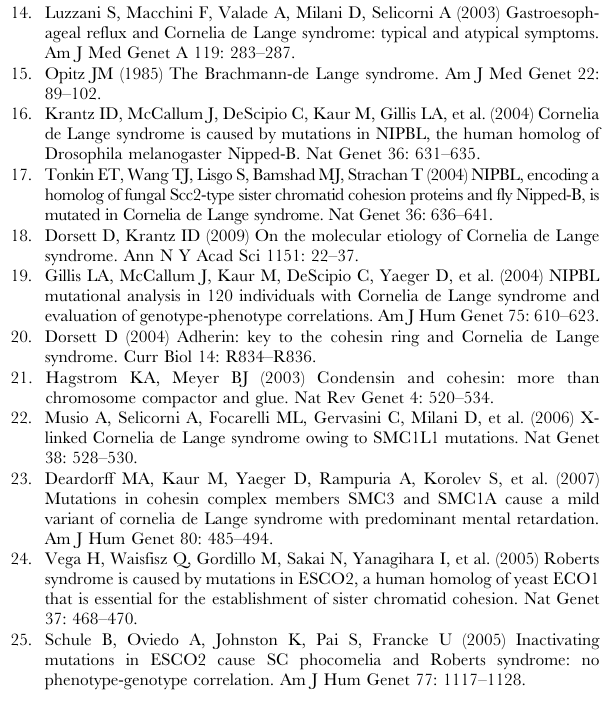
Table S5 Genes displaying expression changes in both Nipbl + / 2 mice (this study) and CdLS lymphoblastoid cell lines [64]. Gene symbols refer to human loci. Where the standard symbols for mouse orthologs are not identical, the mouse symbol is given in parentheses. Found at: doi:10.1371/journal.pgen.1000650.s009 (0.05 MB PDF) Video S1 Circling behavior of Nipbl + / 2 mice. Videos S1, S2, and S3 contrast the repetitive daytime circling behavior displayed by two sibling Nipbl + / 2 mice (Videos S1 and S2) with those of a wildtype littermate (N 1 generation, Video S3). Circling behavior was consistently more pronounced for the animal in this video than in the one in Video S2. MOV) Video S2 Circling behavior of Nipbl + / 2 mice. Videos S1, S2, and S3 contrast the repetitive daytime circling behavior displayed by two sibling Nipbl + / 2 mice (Videos S1 and S2) with those of a wildtype littermate (N 1 generation, Video